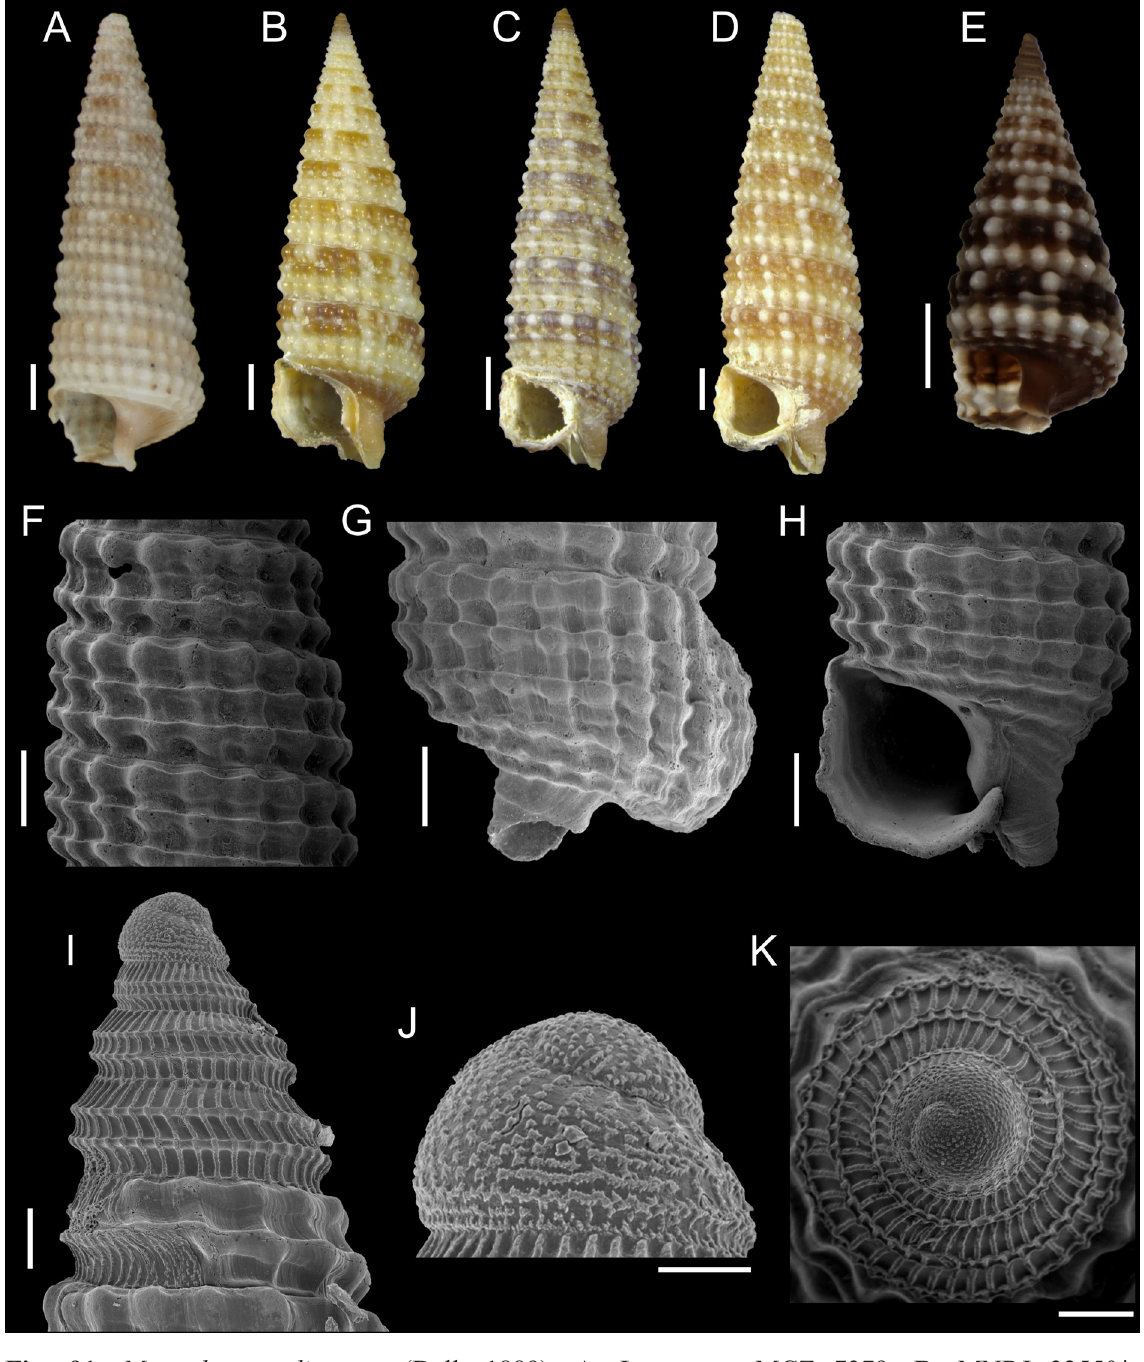
Fig. 91. Monophorus olivaceus (Dall, 1889). A . Lectotype, MCZ 7379. B . MNRJ 32550*, 9.90 mm. C . MNRJ 32925*, 8.66 mm. D . MNRJ 32990*, 11.05 mm. E . MNRJ 18741*, 4.74 mm. F–H . MNRJ 32075*. I–K . MNRJ 17988*. Scale bars: A–E = 1 mm; F–H = 500 µm; I, K = 100 µm; J = 50